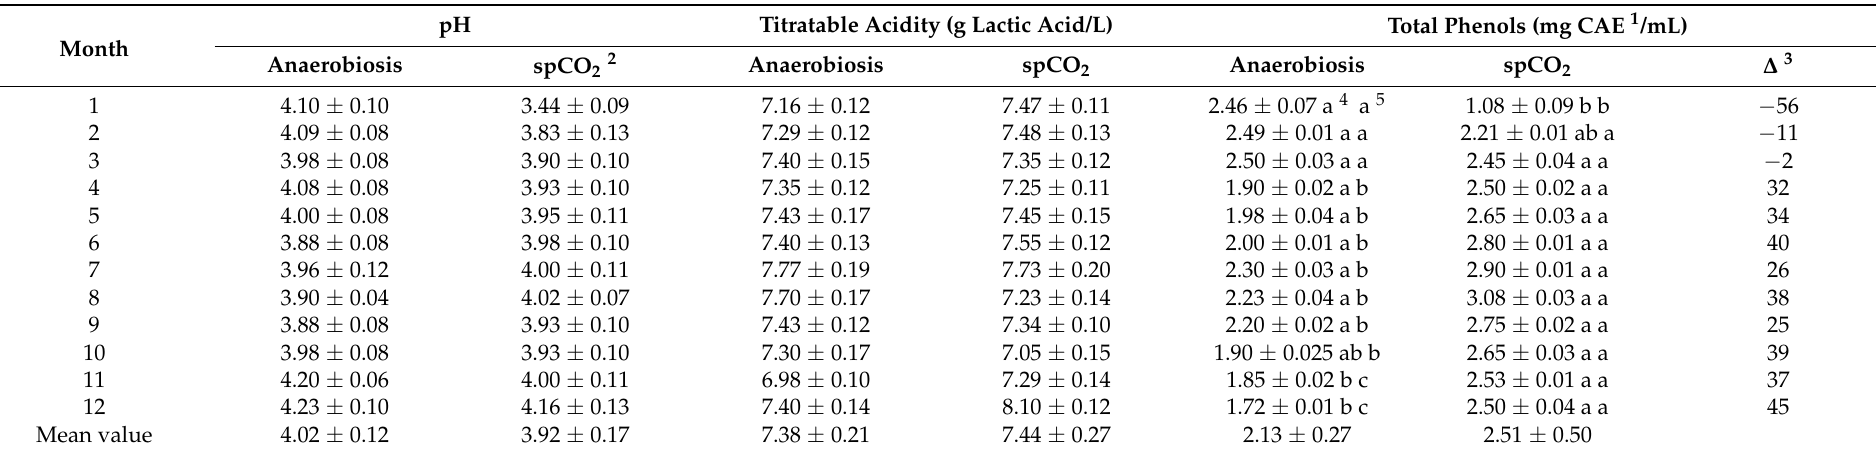
Table 4. Physico-chemical characteristics of naturally processed Leccino table olive brine with 5% NaCl and 0.6% citric acid during one year of incubation under anaerobic and slightly pressurized CO 2